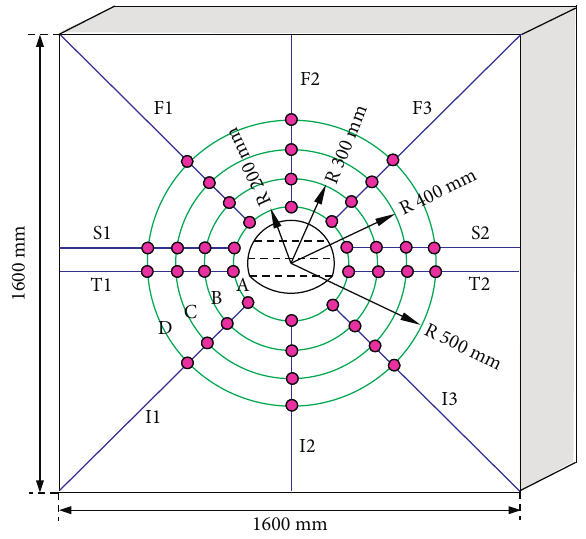
Figure 6: Layout of monitoring section ( y � 5cm) and